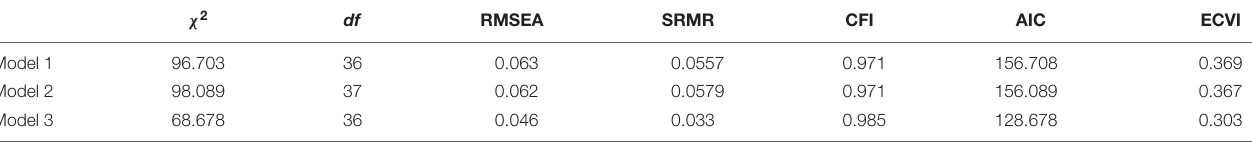
TABLE 2 | Fit indices among competing models.